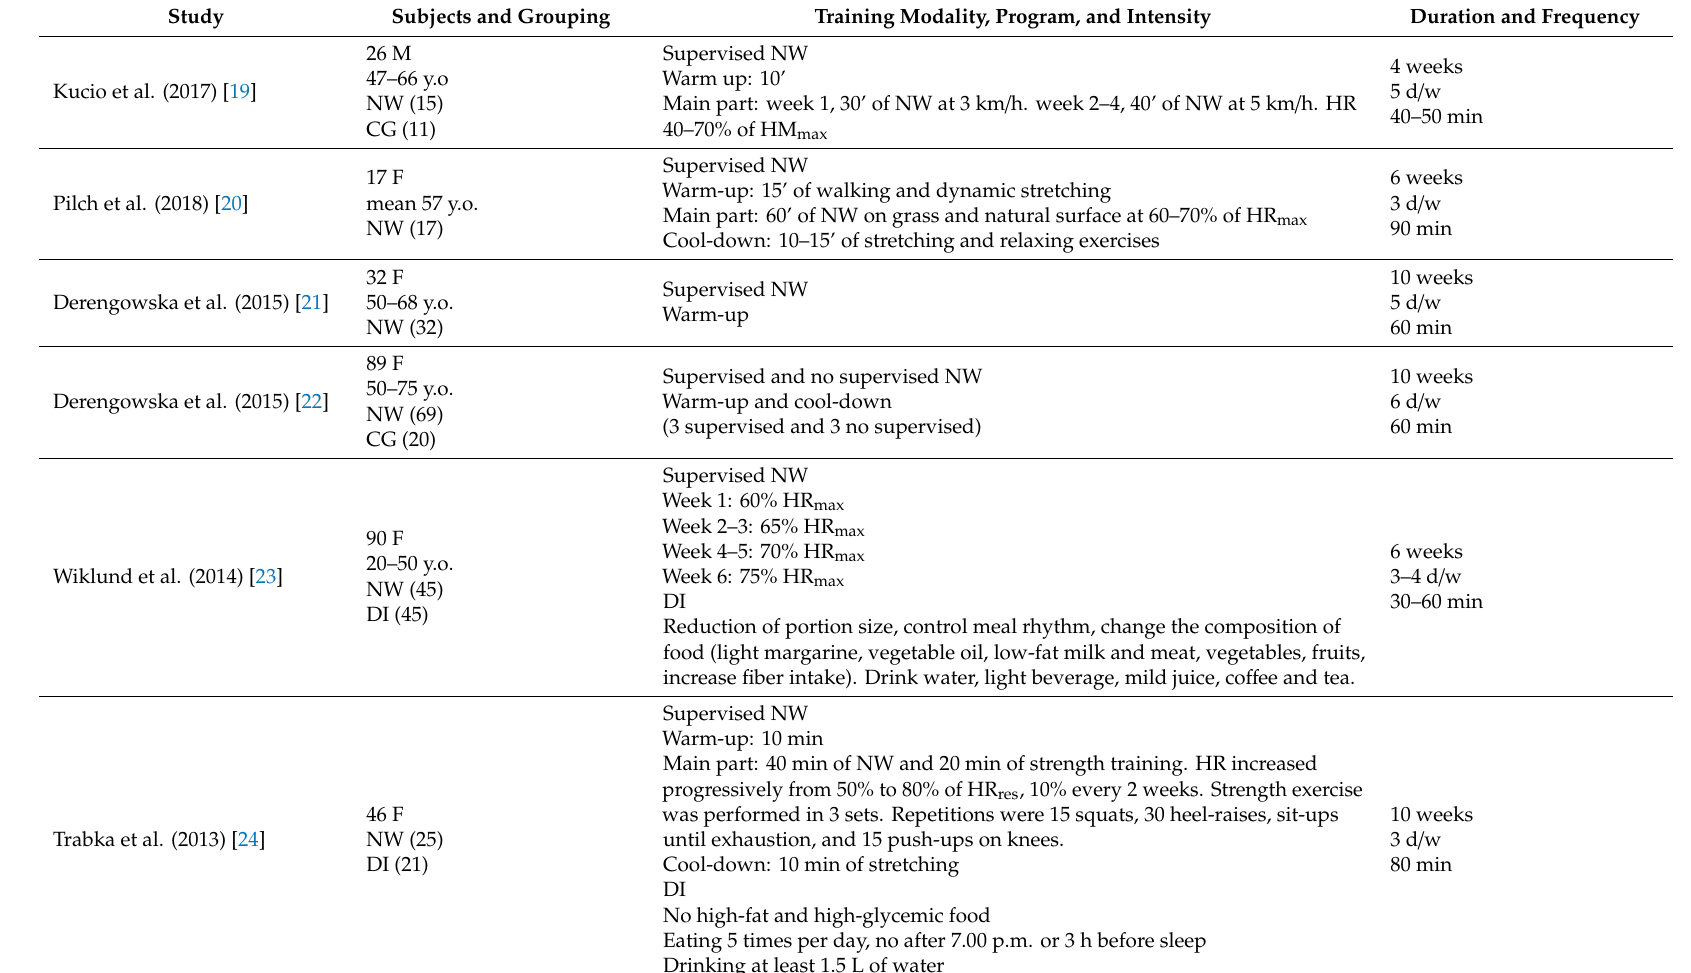
Table 2. Characteristics of the